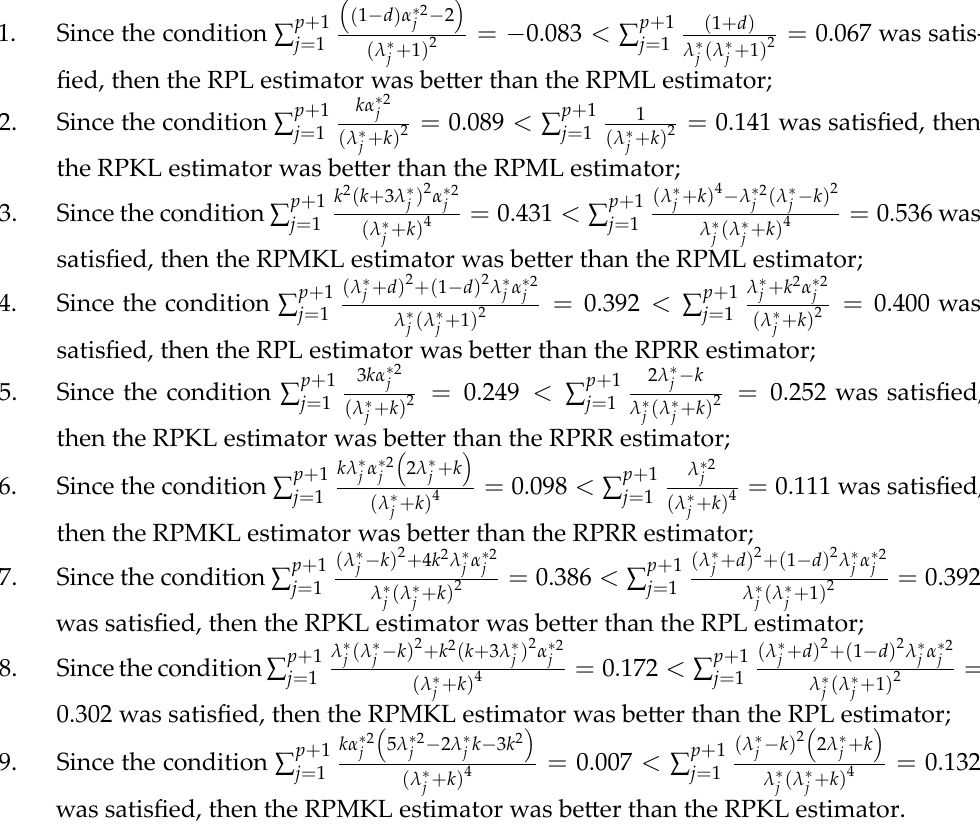
Figure 3. MSE values of the robust estimators against k and d of the aircraft damage data. 4.2. Somerville Lake Data We used a dataset from Cameron and Trivedi [32] to estimate a recreation demand function. These data were from a survey on the number of recreational boating trips in Somerville Lake, East Texas, in 1980. The sample size was 201 observations with one re- sponse variable (y) and three explanatory variables (X’s): y was the number of recreational boating trips in Somerville Lake in 1980, X1 was the cost of visiting Lake Conroe, X2 was